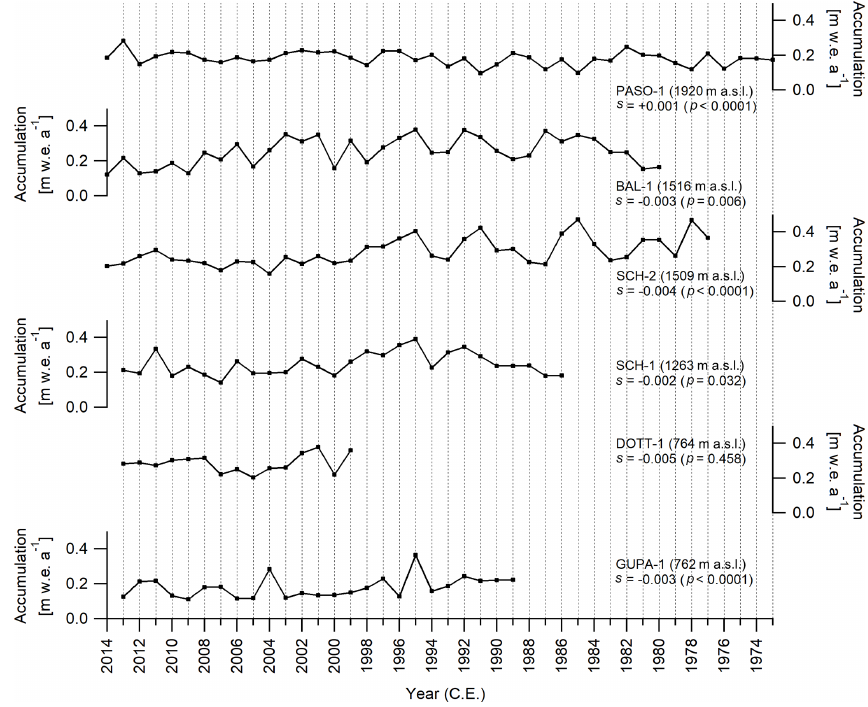
Figure 6. Annual accumulation rates at the drill sites of the six firn cores from UG for the period covered by the respective firn core. Sen slopes ( s in mw.e.a − 1 ) and p values ( p ) are given for all firn cores, indicating that snow accumulation has decreased at most sites since the beginning of the respective record